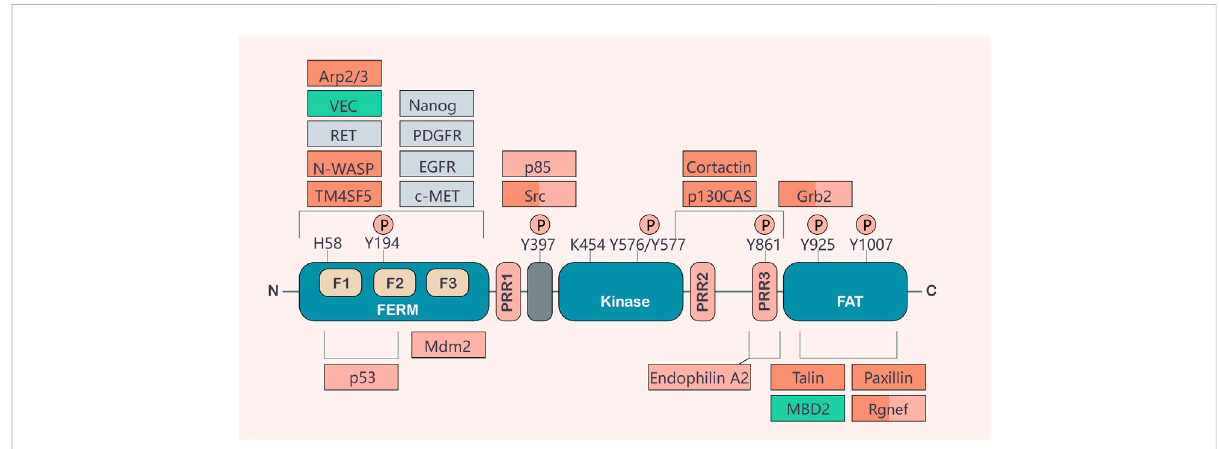
FIGURE 1 Basic structure and function of FAK. FAK consists of a central activation region and a protein band [4.1-Ezrin-Radioxin-moesin (FERM)] homologous structural domain located at the amino terminus and a carboxy-terminal focal adhesion targeting (FAT) structural domain. These two terminal structural domains are separated from the activation domain by a linker region containing proline-rich regions (PRRs). Important tyrosine phosphorylation (P) sites include Y397, K454, and H58, which play key roles in FAK activation. FAK binding partners are shown at their sites of interaction in FAK. The binding of different partners affects functions, such as cell motility (red), cell survival (orange), or both (red/orange). Actors involved in FAK activation are shown in gray, and important contributions to the tumor environment are shown in green (Sulzmaier et al.,